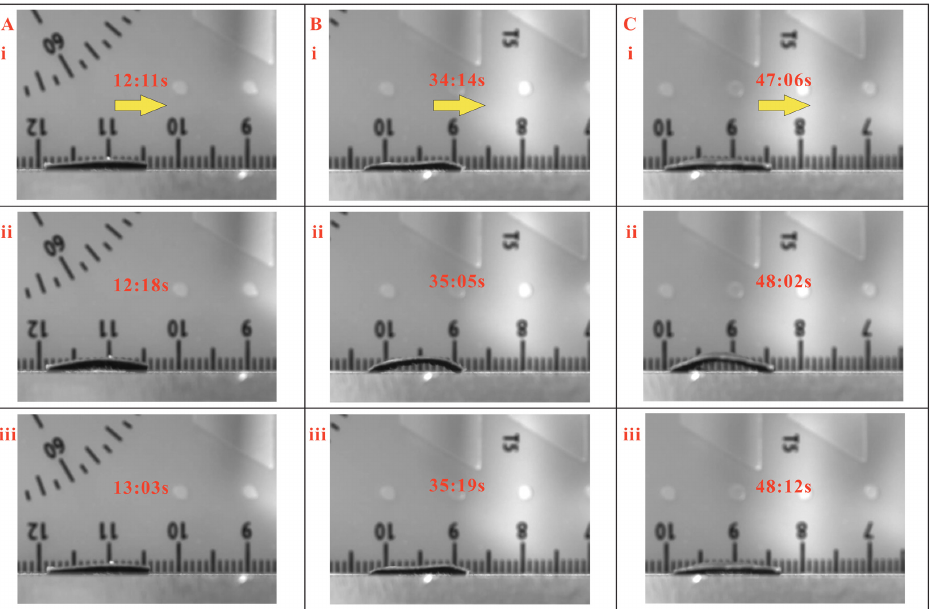
Figure 5. Locomotion test results of magnetic inchworm robots with 400 µm micropillars. ( A ) Stretched length is 1 mm, and the step size is about 0.39 mm. ( B ) Stretched length is 1.25 mm, and the step size is about 1 mm. ( C ) Stretched length is 1.5 mm, and the step size is about 1 mm. In each subfigure, the yellow arrow represents the movement direction. i, ii, and iii indicate the snapshots at different